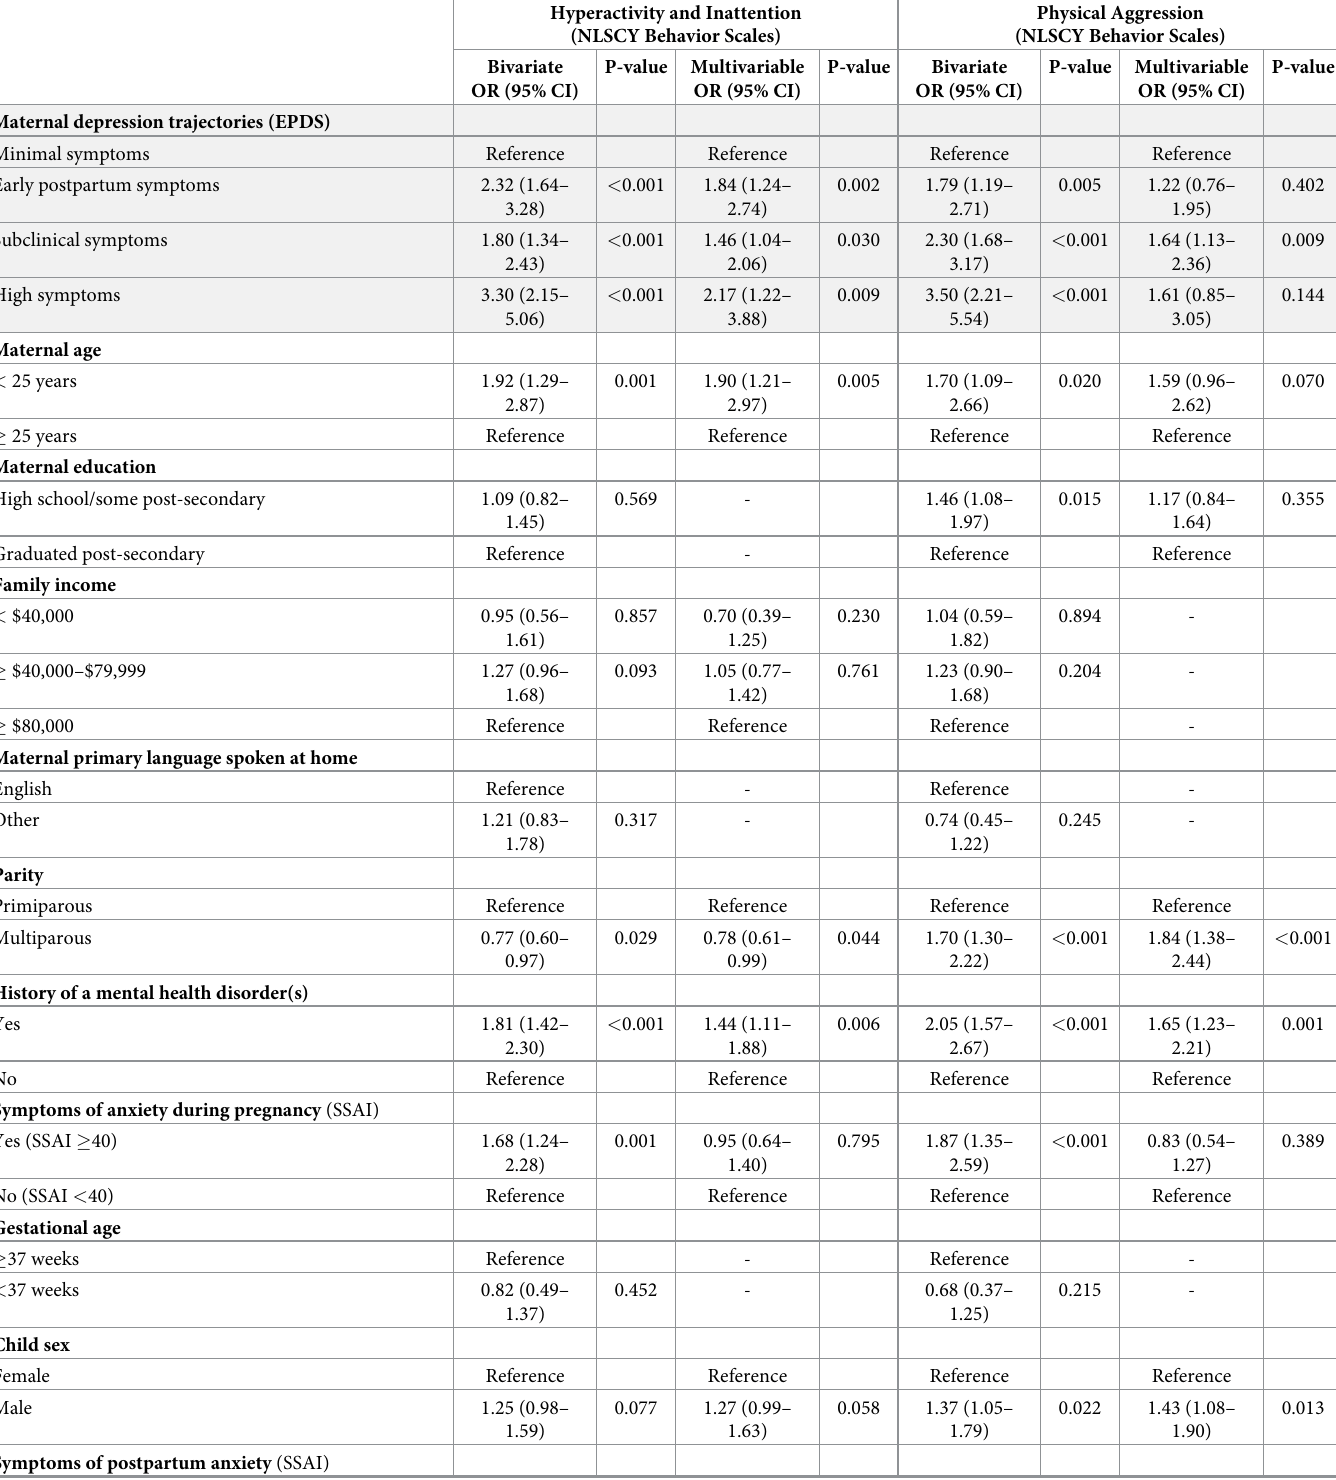
Table 5. Bivariate and final multivariable logistic regression models predicting children’s externalizing behaviors (hyperactivity and inattention and physical aggression) at age